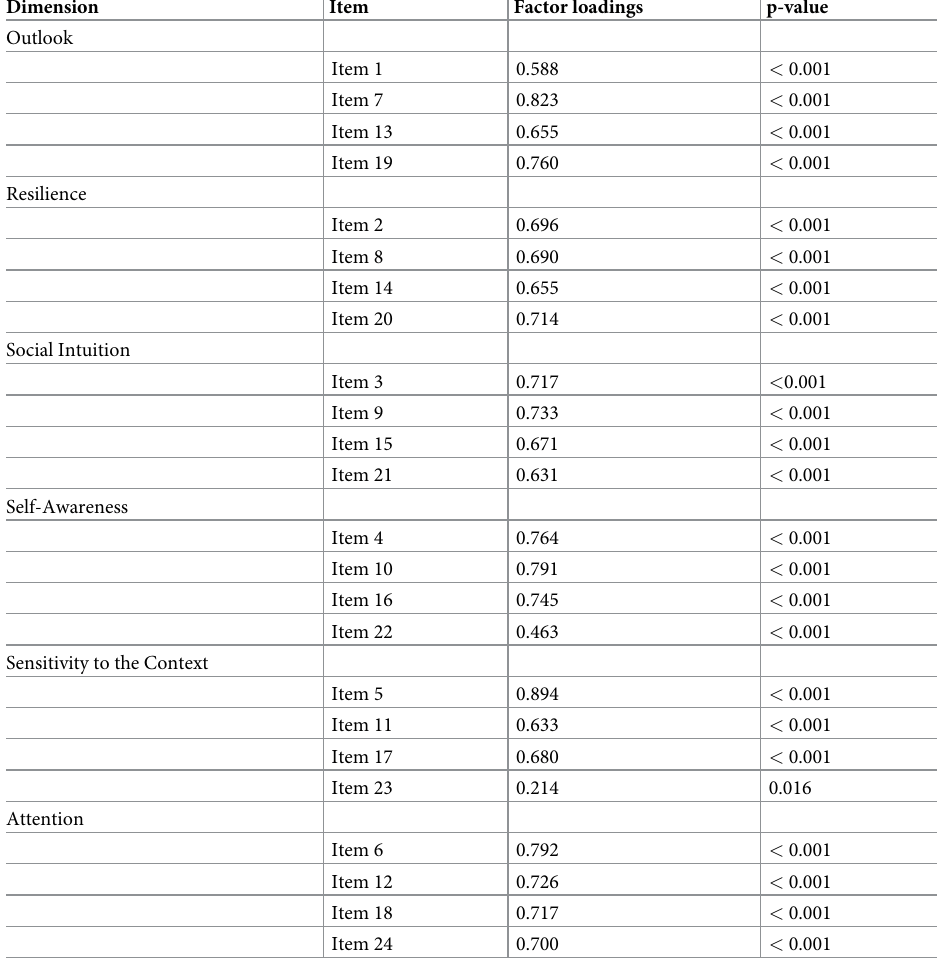
Table 2. Study 2 results related to the Confirmatory factor analysis (CFA) after exclusion of subjects with anxiety and depression cutoffs greater than 10 and 14